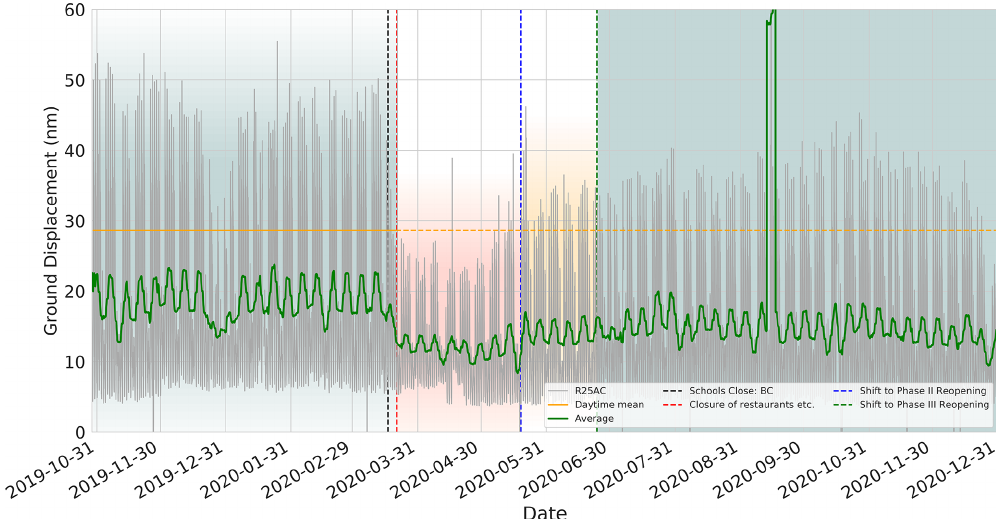
Figure 1. Filtered (4–14Hz) ambient seismic noise displayed as displacement from station R25AC (vertical component) located in Van- couver, British Columbia. Thirty minute average PPSD (dark grey) with rolling mean (window size = 92h) shown in green. The timing of different lockdown scenarios for British Columbia are shown as vertical dashed lines. Background colours represent different lockdown sce- narios: green represents before and after lockdown scenarios, red is the first lockdown scenario with the closure of schools and restaurants, and yellow is the second lockdown scenario where some businesses re-opened. A clear reduction in the average ground motion is observed following initial lockdown conditions in March 2020. The large peak in noise in September is thought to be meteorological, rather than a sudden increase in anthropogenic activity. Figure courtesy of codes developed by Thomas Lecocq and Fred